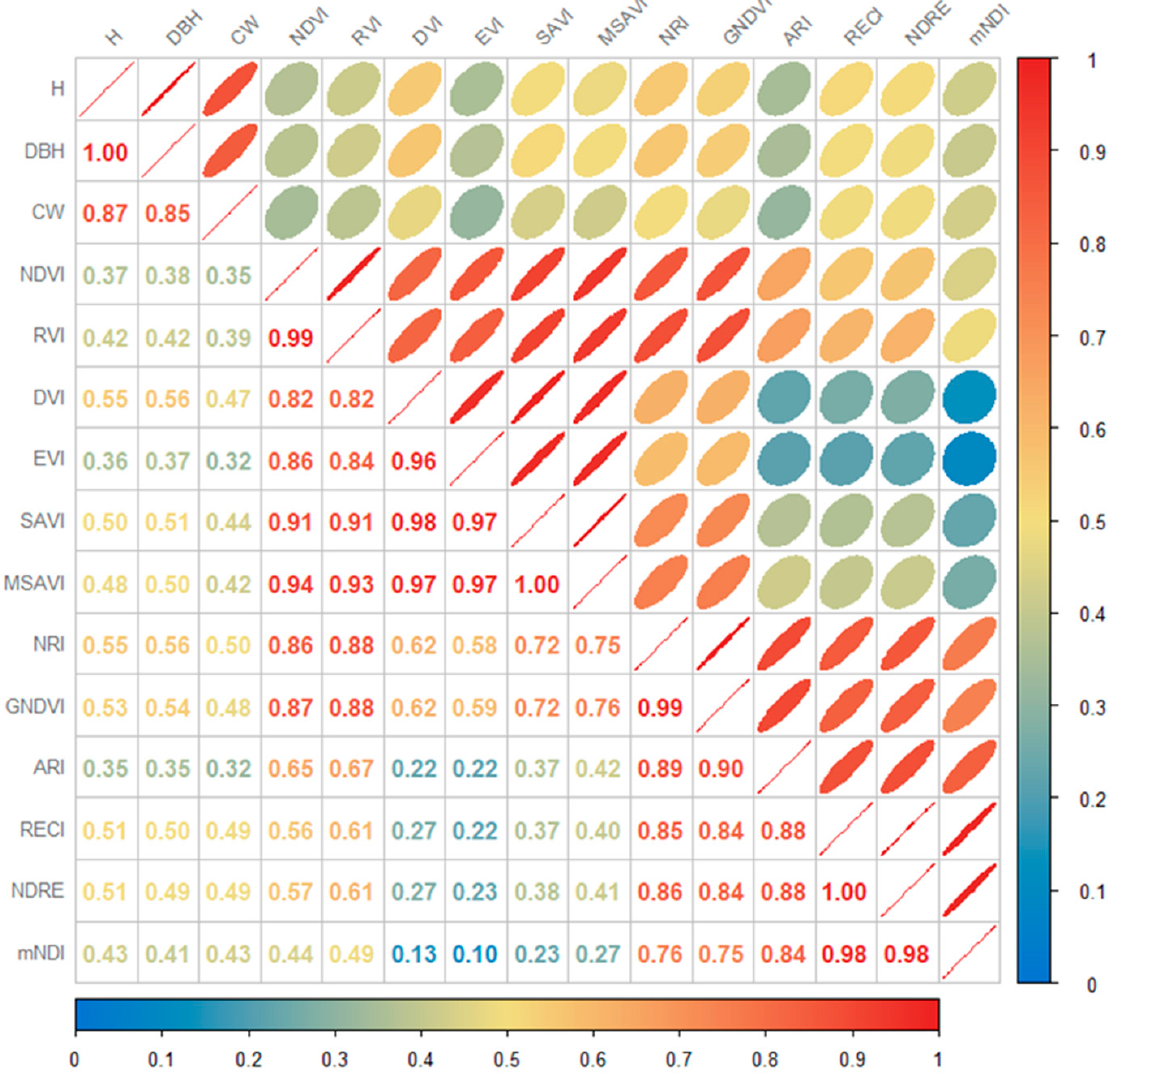
Figure 8. Genetic correlation matrix among 15 traits extracted from UAV multispectral data. The genetic correlation coefficients among all the extracted traits were positive, and the absolute values of the correlation coefficients are represented by the “red-yellow-blue” color band.